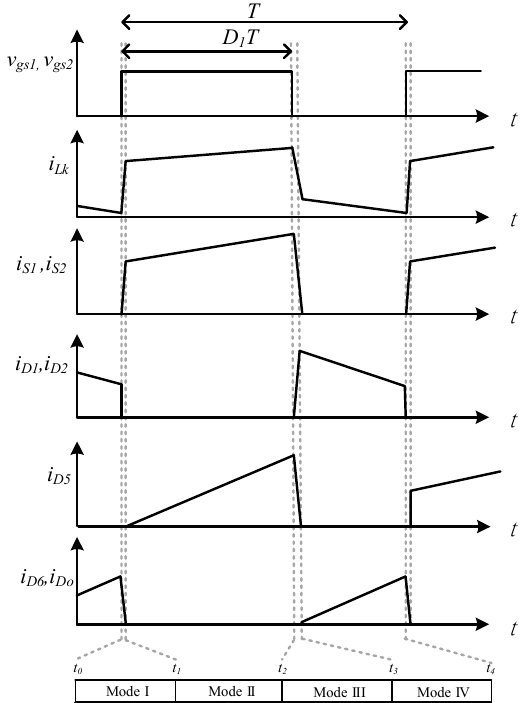
Figure 5. Conceptual key waveform of the proposed converter at SIO (single-input operation) and CCM operation.